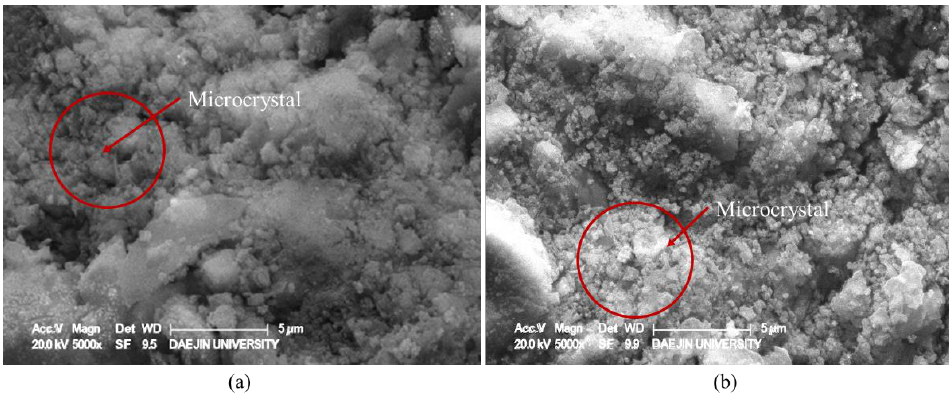
Figure 19. Detailed images of the formation of microcrystals inside the hardened body after the carbonation reaction (×5000). ( a ) Accelerated Carbonation and ( b ) Lean Carbonation.